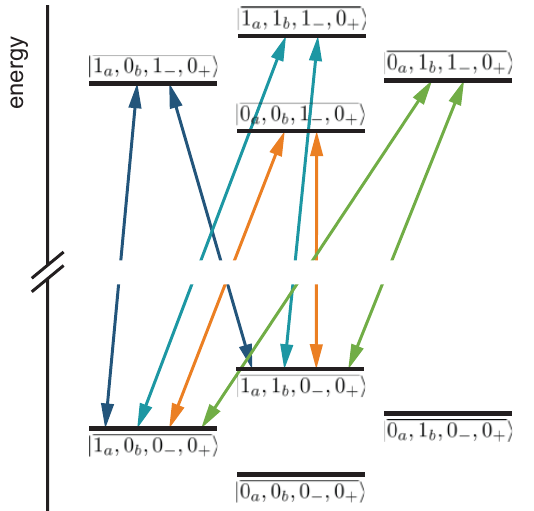
FIG. 10. A schematic of the unwanted transitions in the com- putational subspace. These transitions are due to virtual exci- tations of the higher-lying states | (cid:9) a , m b , 1 − , 0 + (cid:5) , (cid:9) , m ∈ { 0, 1 } mediated by the drive operator h c . As an example, we show the four perturbative paths contributing to the undesired transition (cid:5) ↔ | 1 (cid:5) | 1 a , 0 b , 0 − , 0 + a , 1 b , 0 − , 0 +